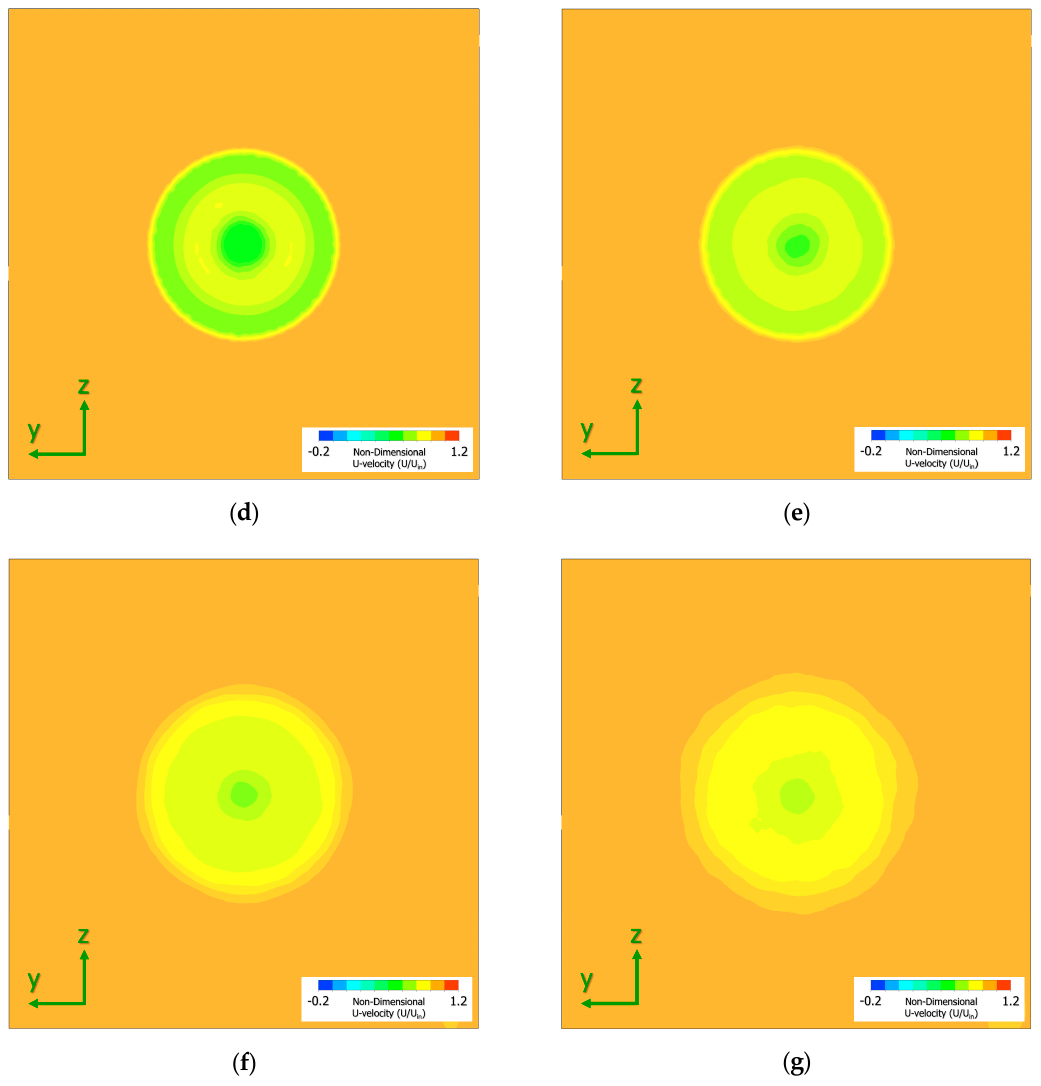
Figure 9. Spatial distribution of U-velocity for time-averaged flow field: ( a ) x–z plane (top view), ( b – g ) y–z plane (rear view). ( b ) x = 0.5 D, ( c ) x = 1.0 D, ( d ) x = 2.0 D, ( e ) x = 4.0 D, ( f ) x = 6.0 D, and ( g ) x = 8.0 D.